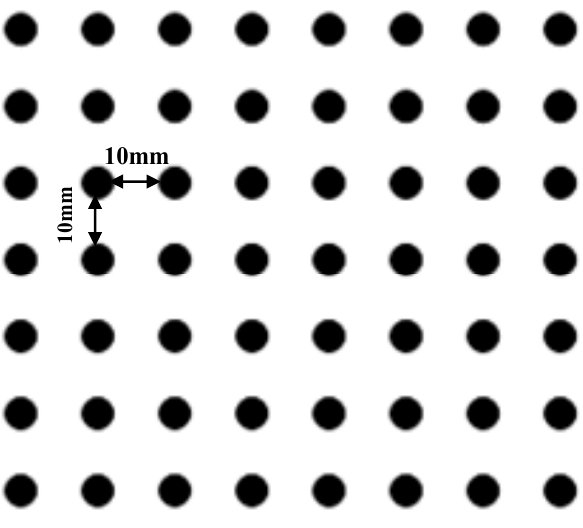
Figure 7. Coplanar reference